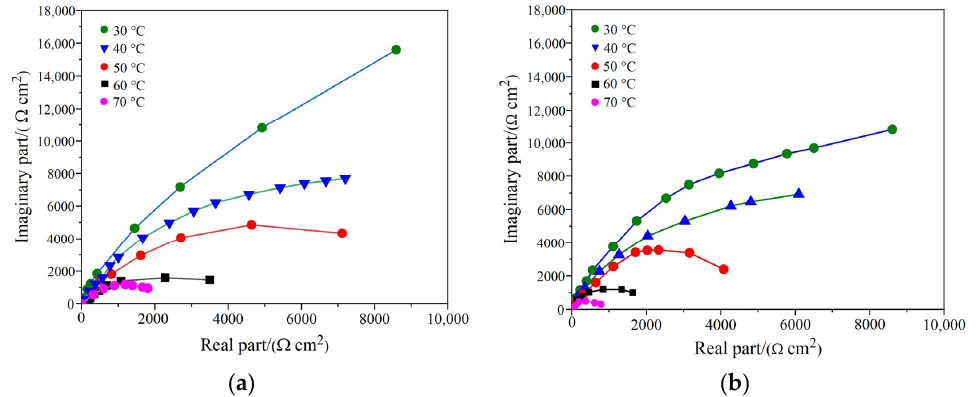
Figure 9. ( a ) Nyquist plots of as-sprayed coating in 3.5% NaCl solution; ( b ) Nyquist plots of coat-